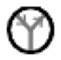
(A) Schematic drawing of the experimental approach/mouse brain. AI, primary auditory cortex; CN, cochlear nucleus; ESAI, focal electrical stimulation of the AI; ICc, central nucleus of the inferior colliculus; MGBv, ventral division of the medial geniculate body; : a switch between recording system and stimulation system. (B) Examples of ESAI-evoked changes in membrane potentials of ICc neurons and their frequency tunings (AI—gray areas and the ICc—black curves in the grid fields). EPSP and IPSP, excitatory and inhibitory postsynaptic potentials (PSPs).